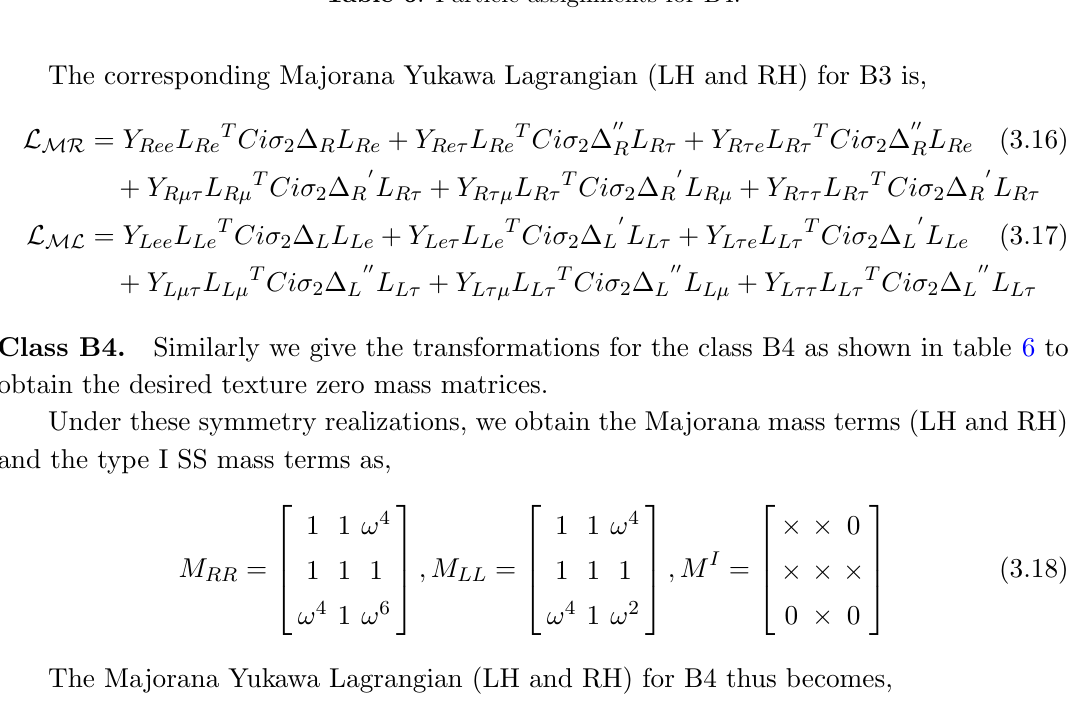
Table 6 . Particle assignments for